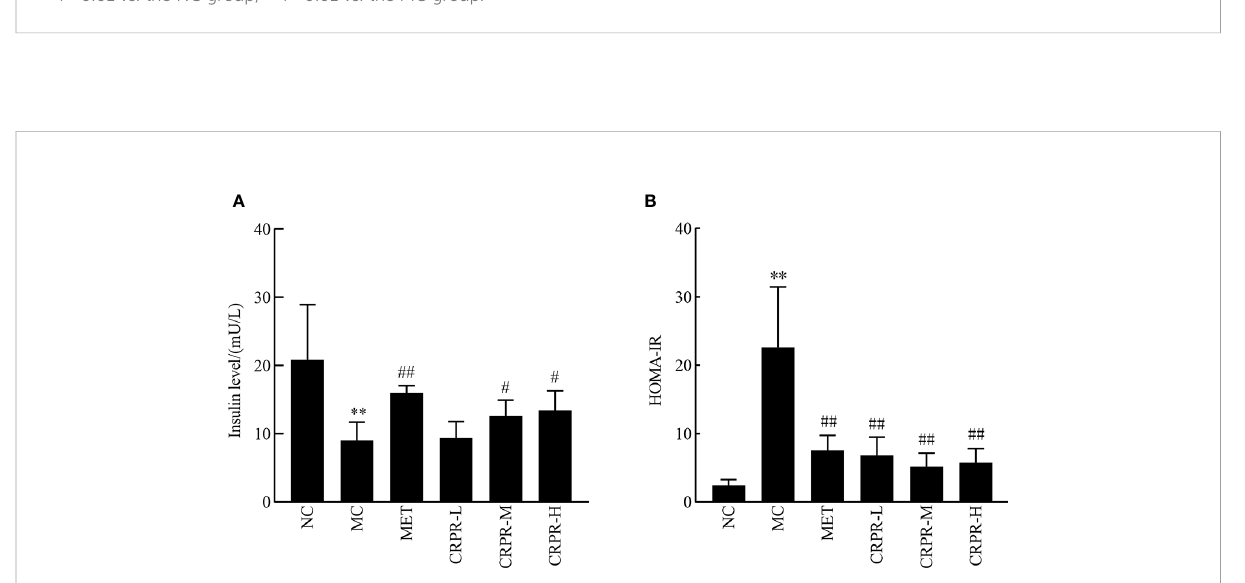
FIGURE 4 Effect of CRPR on insulin and HOMA-IR in T2DM mice. (A) Effect of CRPR on insulin levels. (B) Effect of CRPR on HOMA-IR. All values are presented as the mean ± SD. ** P <0.01 vs. the NC group; # P <0.05 and ## P <0.01 vs. the MC group.